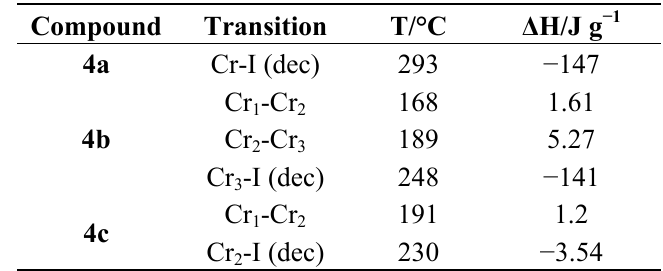
Table 3. Transition temperatures and enthalpy changes for the cobalt(II)